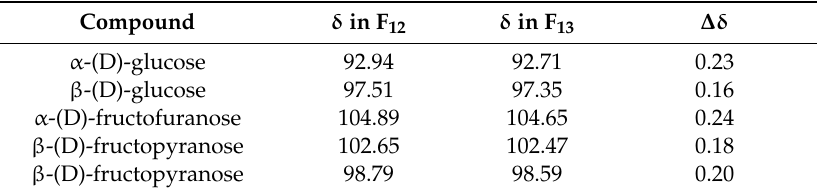
Table 2. Matrix e ff ects of chemical shifts of sugars anomeric